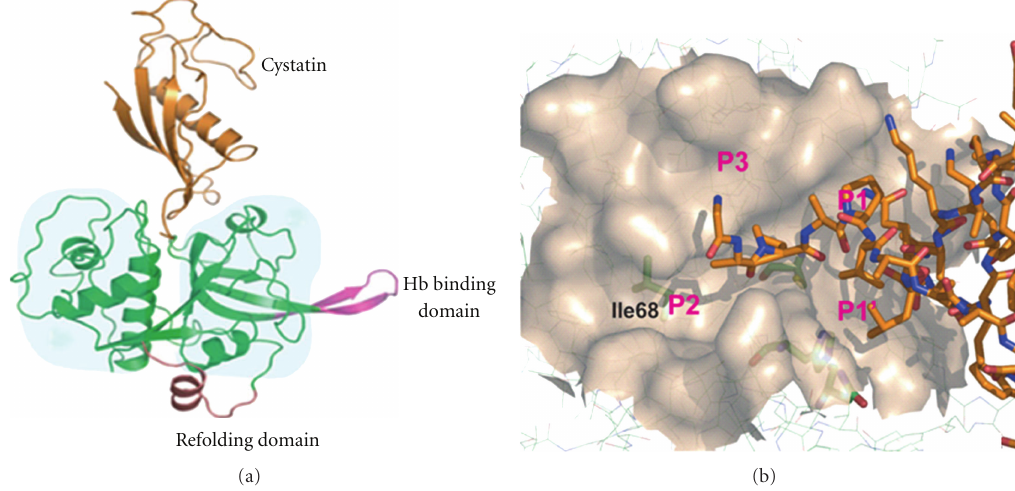
Figure 6: (a) 3D structure of falcipain-2-cystatin complex. Cystatin is colored in orange, and falcipain-2 protease is colored in green. Refolding domain and hemoglobin binding domain highlighted in pink and salmon, respectively. The shaded area in the figure corresponds to the size of human cathepsin H, superimposed on falcipain-2 in light blue. (b) The catalytic Cys, His, and Asn are depicted in stick mode in green, and substrate binding pockets are labeled P3 to P1 (cid:3) . Ile-68 at P2 is depicted in stick mode to illustrate a slight protrusion in the S2 pocket of falcipain-2.